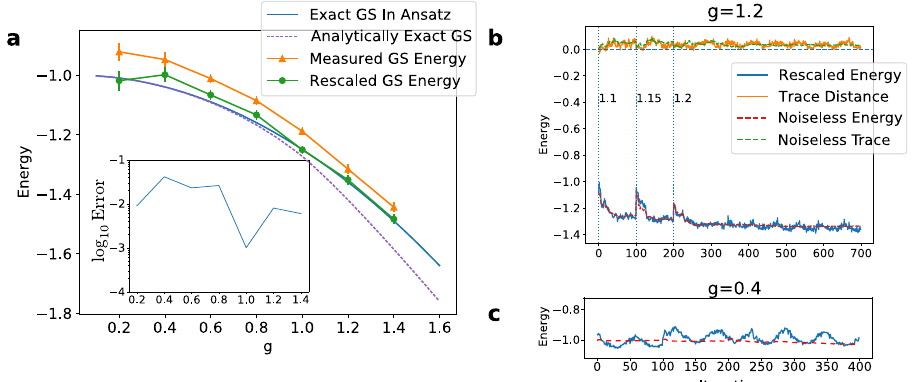
Fig. 2 | Optimisation of groundstates of the quantum Ising model. a The blue curve gives the exact energy of the quantum Ising model optimised over bond order D =2MPSwithintheansatzclassusedonthedevice.Thedashedpurplecurve gives the analytically exact groundstate energy calculated analytically in the ther- modynamic limit 55,56 . The green and orange curves show energies of the optimised on the Rainbow device with and without Loschmidt rescaling to allow for depo- larisation,respectively.Measurementerrorsarecorrectedusingaconfusionmatrix inbothcases.Exceptfortheanomalouspointat g =0.4affectedbyanuncontrolled oscillationonthedevice(see c ),therescaledresultsarewithin2.2%oftheexact-in- ansatz values. Thisistrue even atthe quantum critical point, g =1. The inset shows the log-deviation in measured energy compared to the exact value for the